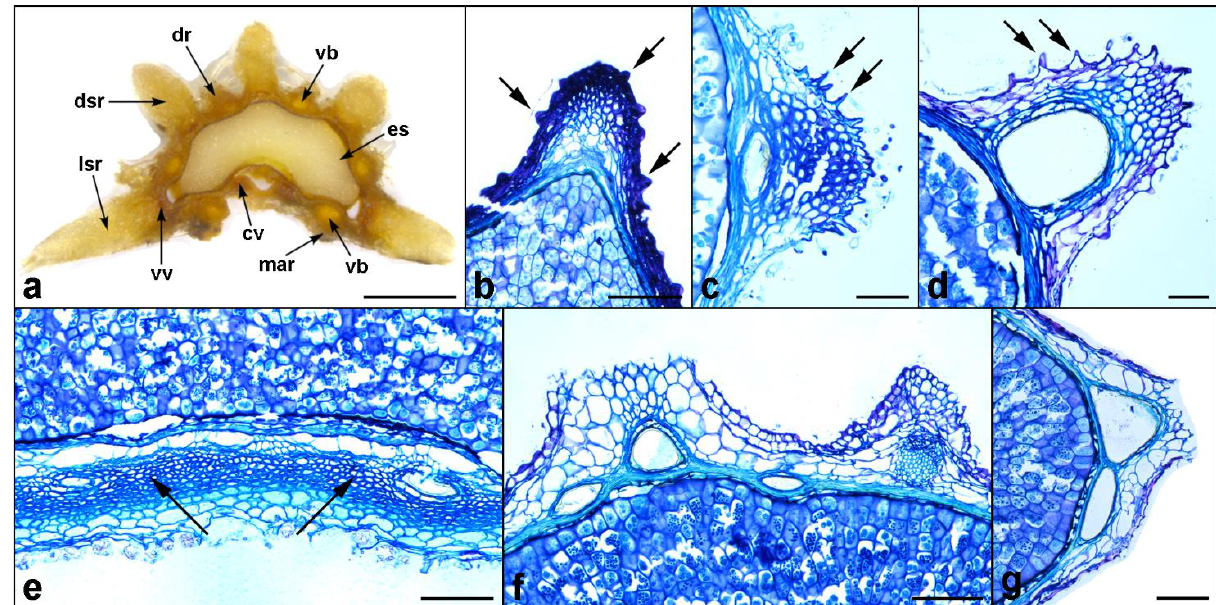
Figure 7. Selected distinct features or abnormalities found in the mericarps of Daucus and related taxa. ( a ) Abnormal mericarp of D . littoralis with additional dorsal primary and secondary ribs; ( b ) tubercles (arrows) on the exocarp of D . aureus ; ( c ) characteristic exocarp cells with triangular appendages (arrows) covering the primary ribs of D . glochidiatus and ( d ) D . sahariensis ; ( e ) close-up on the commissural side of Orlaya daucoides mericarps showing a hypendocarp (arrows); ( f , g ) additional smaller vallecular vittae in the cultivated carrot mericarps. Abbreviations: cv, commissural vitta; dr, dorsal primary rib; dsr, dorsal secondary rib; es, endosperm; lsr, lateral secondary rib; mar, marginal primary rib; vb, vascular bundle; vv, vallecular vitta. Scale bars: 1 mm ( a ); 50 µm ( c , d ); 100 µm ( b , e – g ).